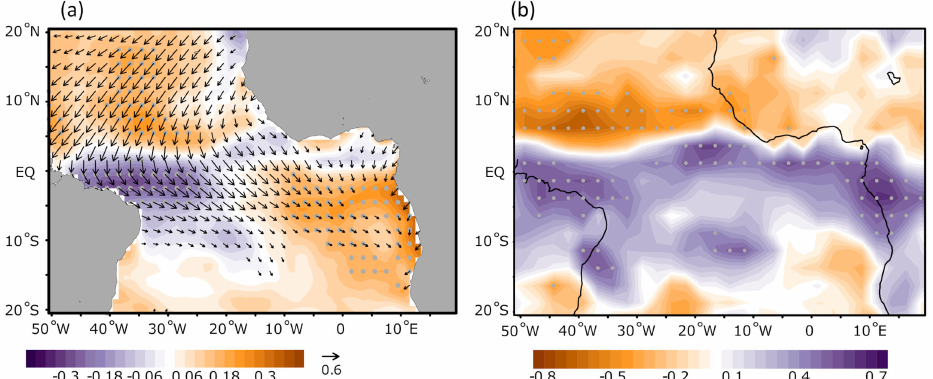
Figure 8. ( a ) Correlation map between PC2 score and latent heat flux (color, TropFlux, 1979–2015, upward is positive) and surface wind stress (vector, ERA-Interim, 1979–2011). The gray dots denote 99% significance level and vector is only shown with 99% significance level. ( b ) same as Figure 4, but for correlation of precipitation with PC2 score in